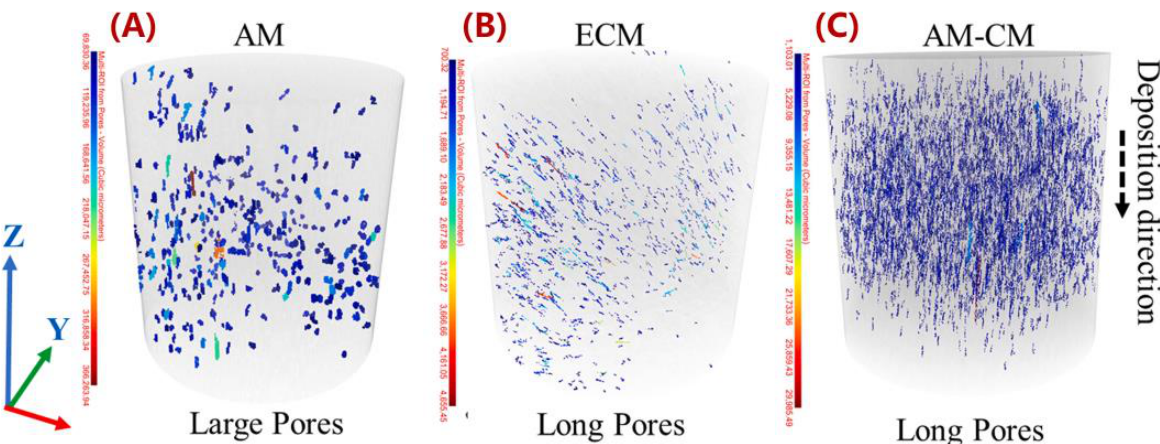
Figure 20. xCT for high aspect ratio pores along the fibers ( A ) AM, ( B ) ECM, and ( C ) AM – CM [101].